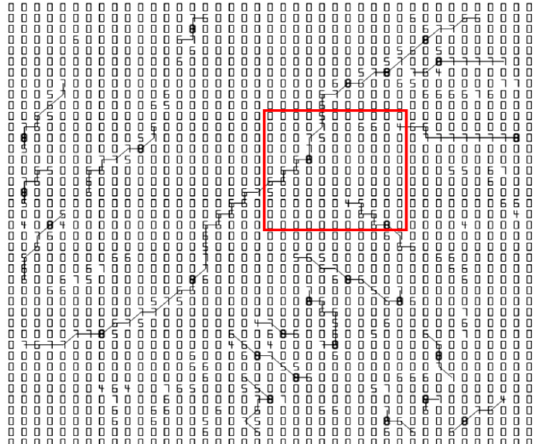
Figure 4 Tracing result of raw trough line using geopotential height field from 2200 UTC on 8 October 2013.